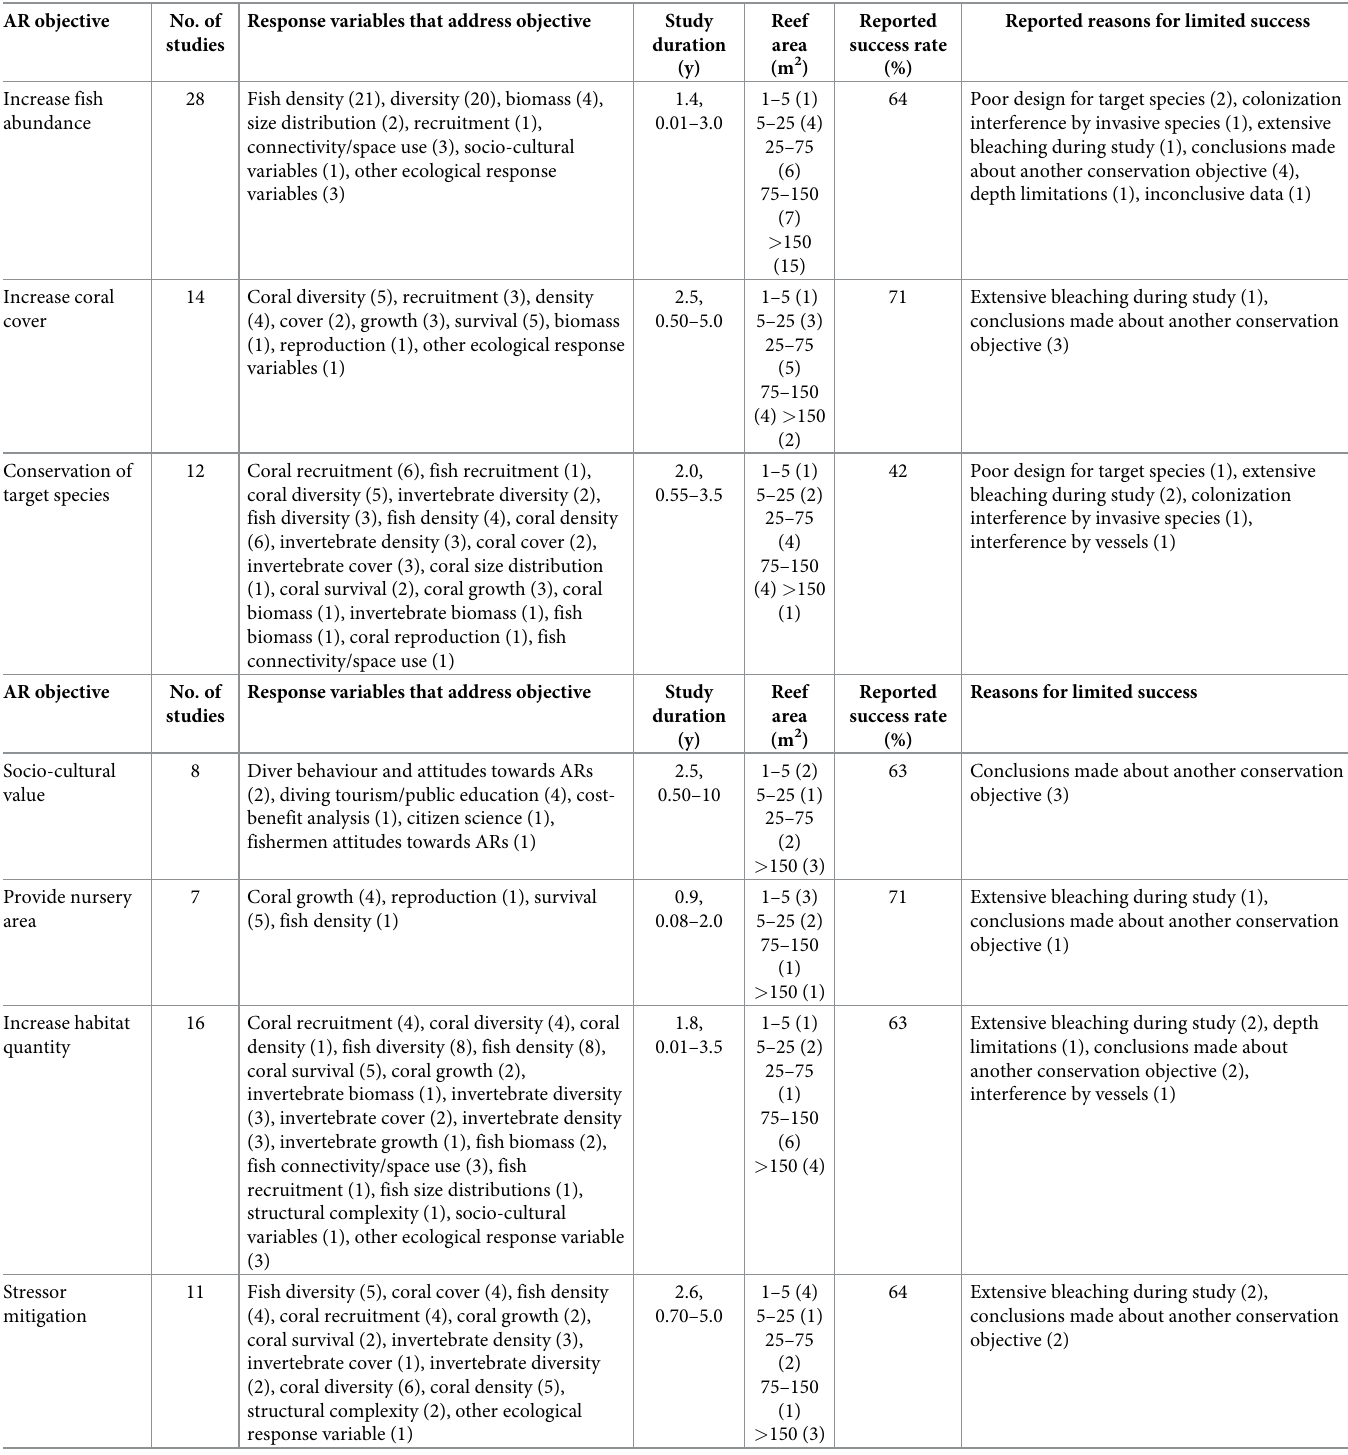
Table 2. AR deployment for conservation objectives (n = 51